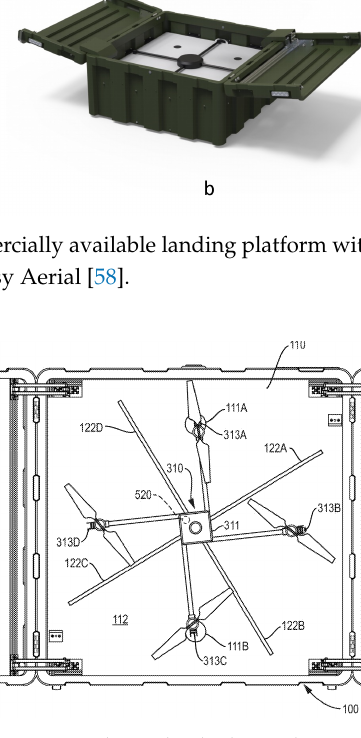
Figure 17. Charging station for unmanned aerial vehicles with a rotating pusher centering mechanism by Easy Aerial Inc. [59]. 110, landing surface; 111a, 111b, electrical contacts on the landing surface; 112, electrical insulating material of the landing surface; 122a, 122b, 122c, 122d, bars of the pusher; 310,